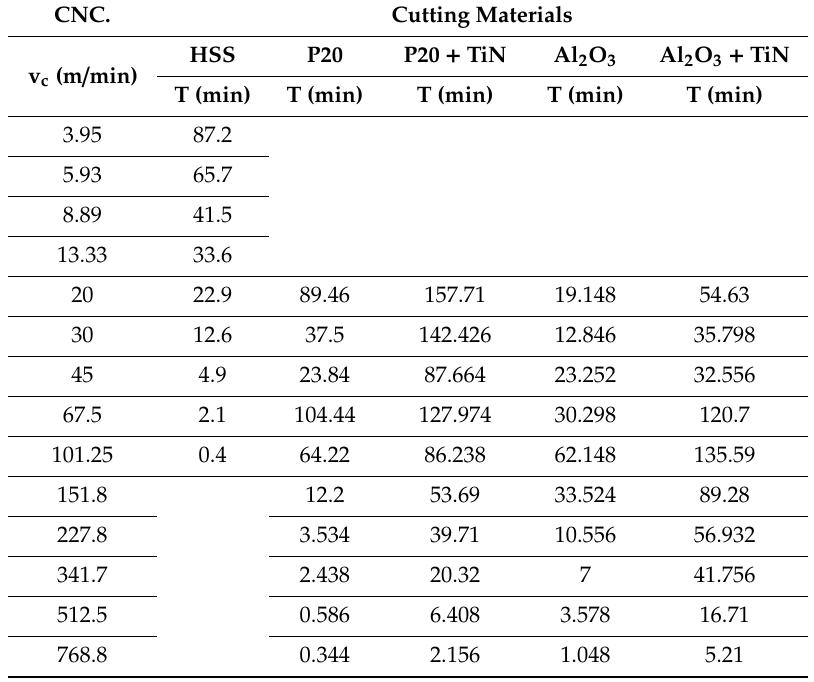
Table 9. T-v c dependences created by the least-squares method (CNC machine). CNC.